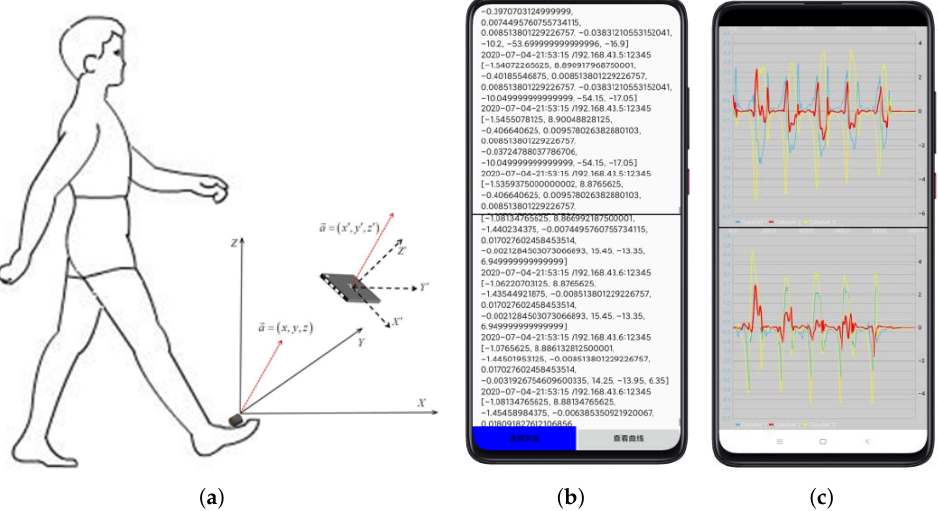
Figure 5. Data acquisition and software interface ( a ) Sensor placement ( b ) Raw data ( c ) Raw data